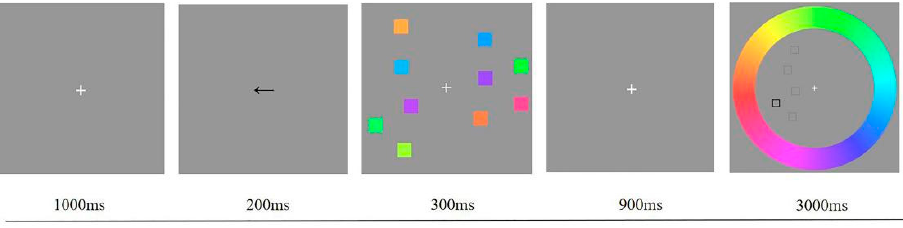
Figure 1. A schematic illustration of the color recall memory task. Each trial started with a fixation cross presented in the center of the screen for 1000 ms. Then, an arrow was presented to randomly point left or right for 200 ms, indicating which side presented memory items. Five memory items on each side of the memory array were kept visible for 300 ms. Followed by a retention interval of 900 ms, the probe array presented a color ring in which five hollow squares in the cued side were located in the same positions as those of the memory array, and the target item was peripherally bolded. ring with the mouse within 3000 ms. The color and positions of memory stimuli were ment was divided into three different phases, each consisting of 300 trials.